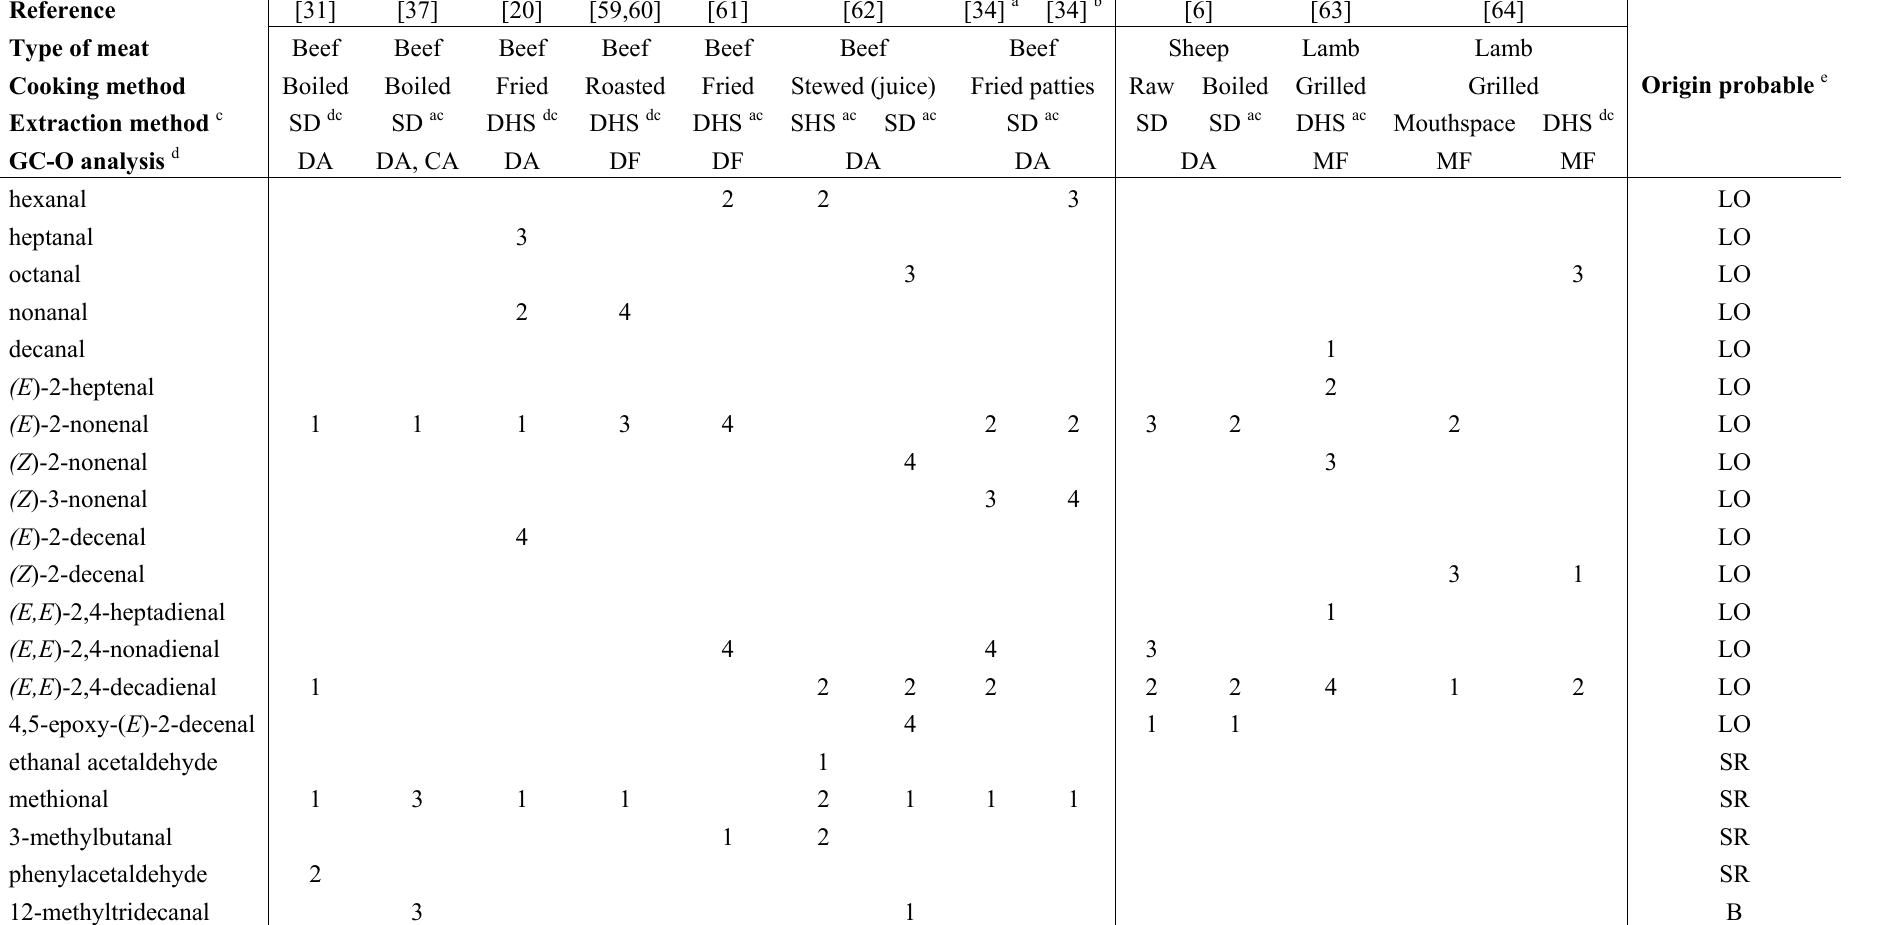
Table 3. The most important carbonyl compounds * in beef and sheep/lamb meat identified using